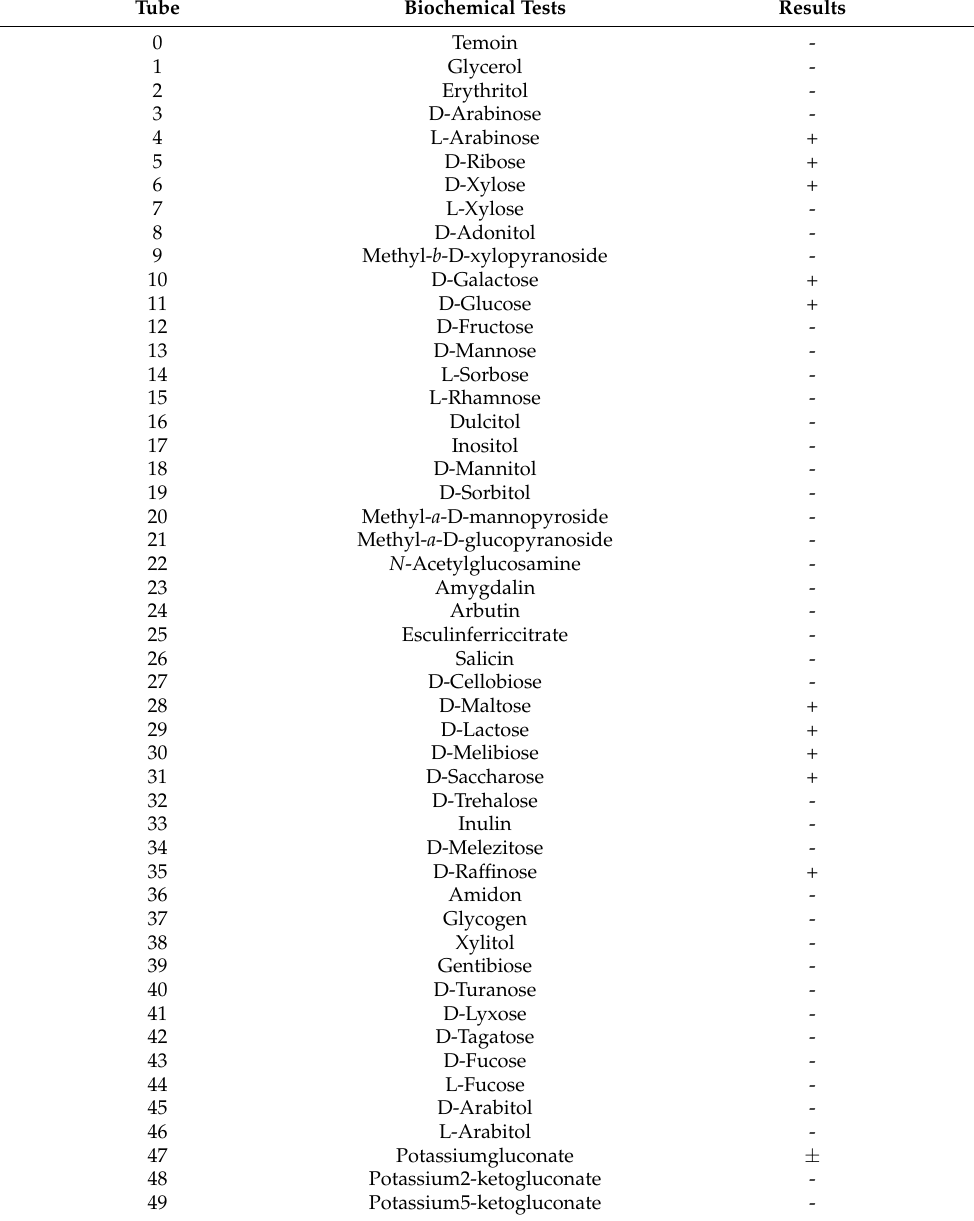
Table 1. Biochemical profile of the API 50 CHL of Limosilactobacillus reuteri